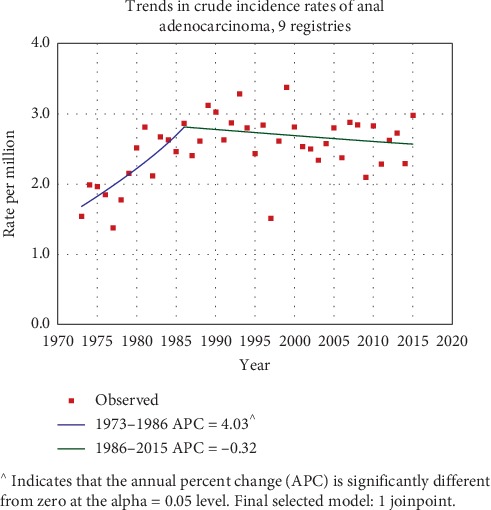
Changing incidence from 1973–2015.